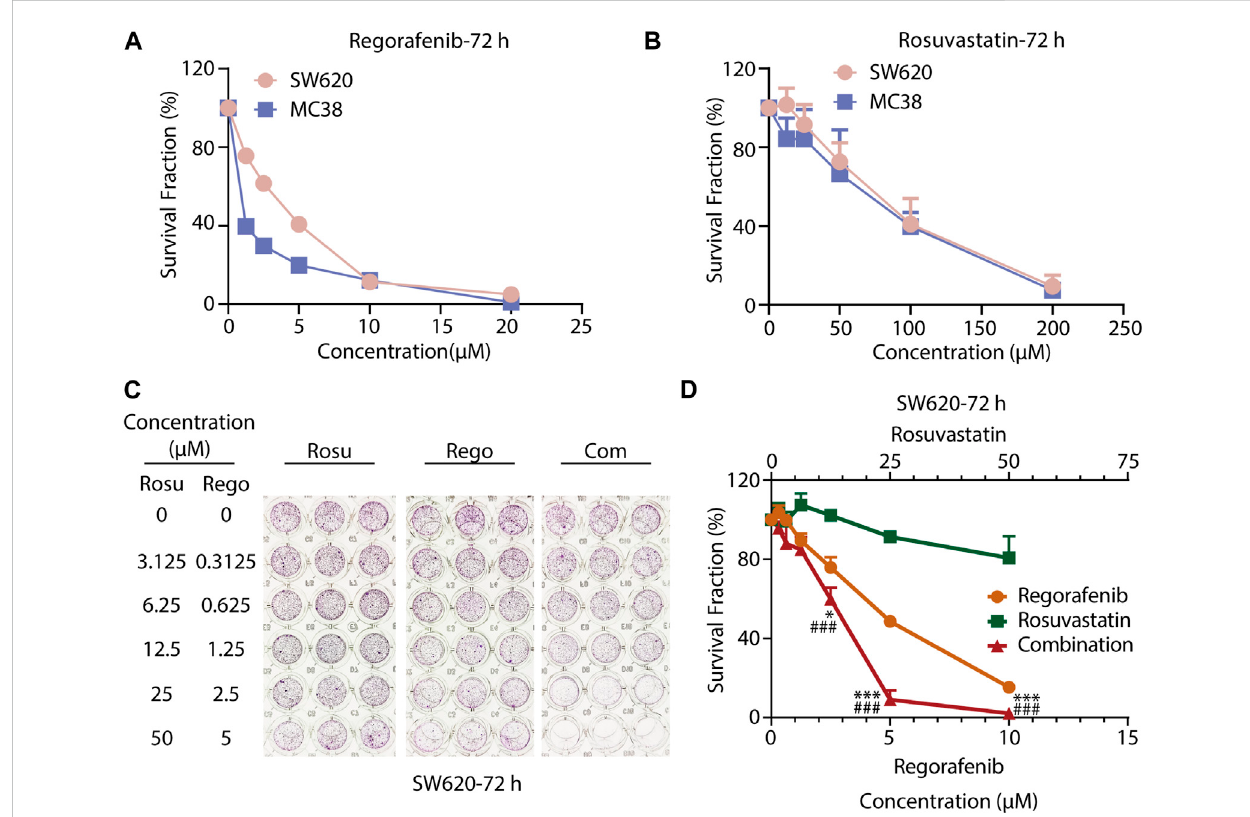
FIGURE 1 Co-treatment with regorafenib/rosuvastatin synergistically suppressed cell proliferation of colorectal cancer cells in vitro . (A, B) SRB assays to examinetheeffectsofregorafenib(range,1.25 – 20 μ M)androsuvastatin(range,12.5 – 200 μ M)onSW620andMC38cellsproliferationfor72 h. (C,D) SRB assaystoexaminetheeffects ofregorafenib,rosuvastatin, andco-treatmentonSW620 cellsproliferation for 72 h.Thedatawereshownas mean±SDof three replicate assays. *, p < 0.05; ***/###, p < 0.001 (*: vs. Regorafenib group; #: vs. Rosuvastatin group). Rosu: Rosuvastatin; Rego: Regorafenib; Com: